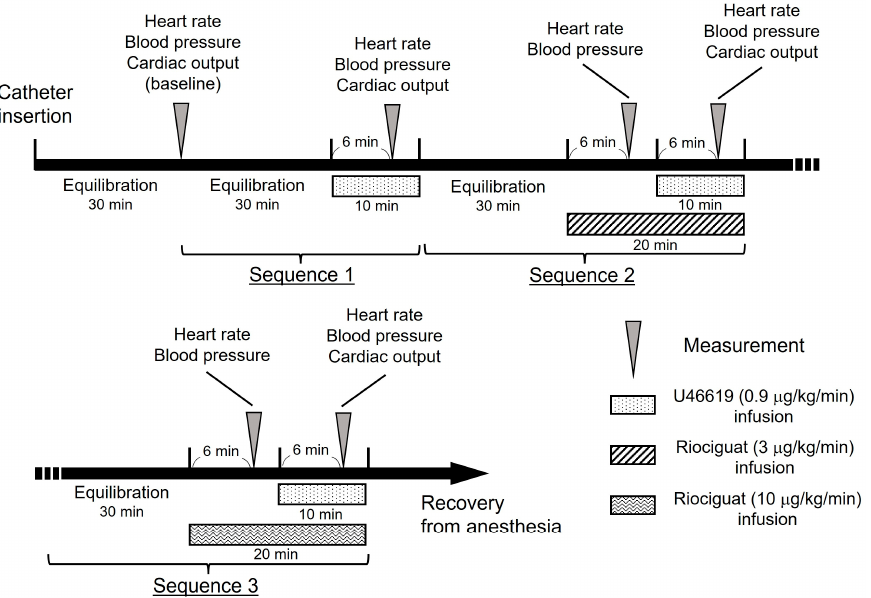
Figure 1. Timeline of the study protocol. The drug sequences 1 to 3 were randomized for each